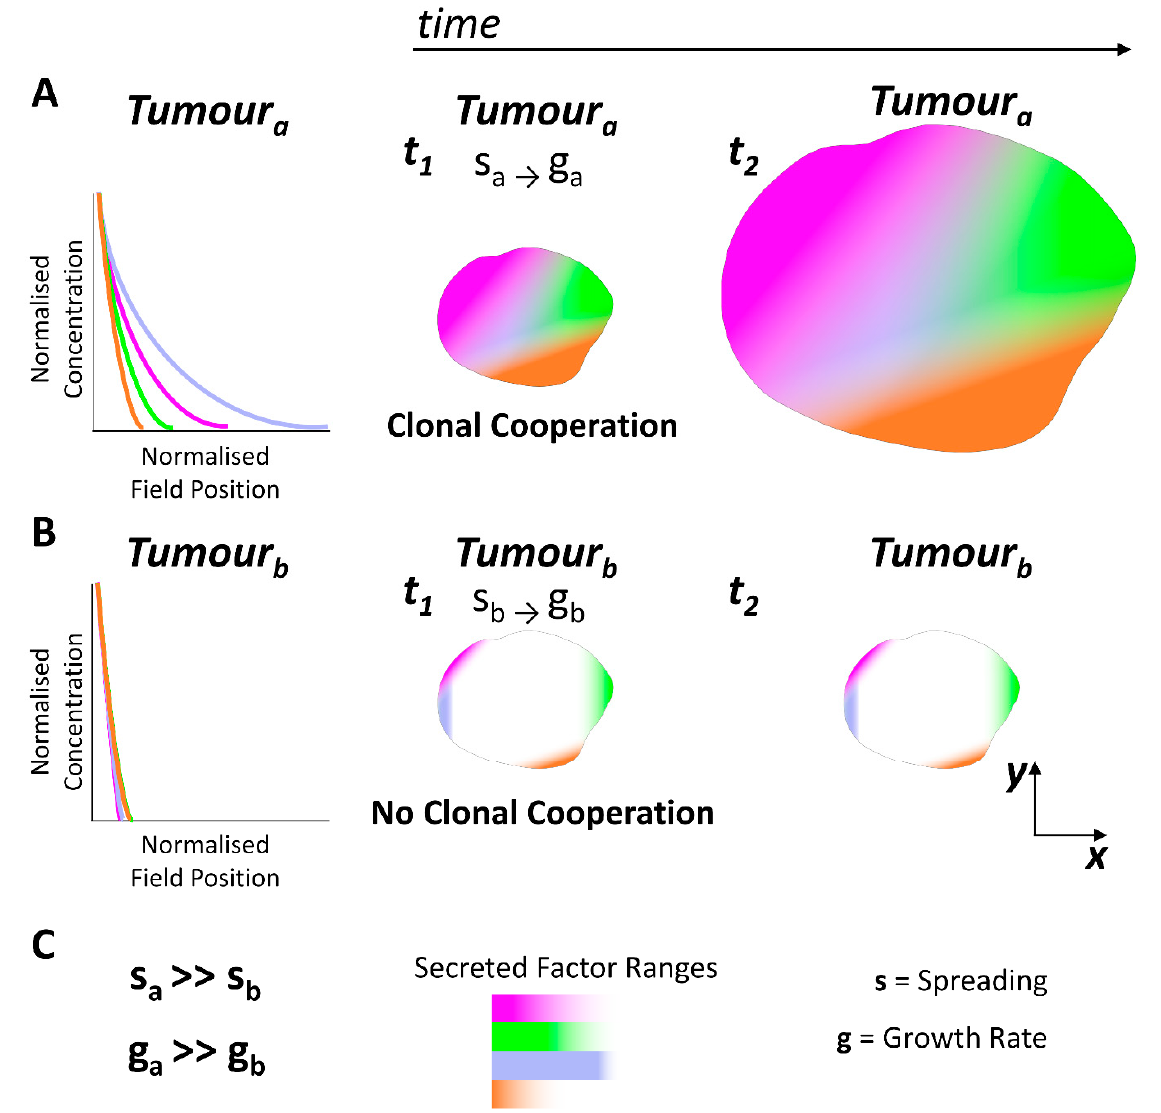
Figure 3. Clonal cooperation and tumoral growth. During tumoral growth, different clones/subclones of cancer cells are generated, which can act as secreted factor sources, boosting tumoral growth. The spread of these secreted factors depend on the biophysical properties of the tumoral field. ( A ). Depicted plot showing normalized secreted factor concentration vs. normalized field position within the tumoral field a . Different colours depict different secreted factors. Tumoral field a (tumour a ), shows high spreading biophysical properties, increasing the range of these secreted factors throughout the tumoral field. These can lead to clonal/subclonal cooperation, increasing the proliferation of cancer cells and therefore boosting tumoral growth rates ( g ). ( B ). Depicted plot showing normalized secreted factor concentration vs. normalized field position within the tumoral field b . Different colours depict different secreted factors. Tumoral field b (tumour b ) shows low spreading biophysical properties; thus, secreted factors spread over small ranges within the tumoral field. Small ranges of secreted factors in the tumoral field can abolish clonal cooperation and decrease tumoral growth rates (g). ( C ). s : refers to the spreading ranges of secreted factors; g : refers to the tumoral growth rate; t : refers to time.